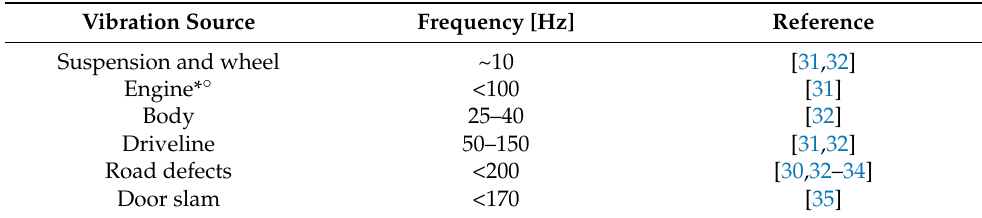
Table 1. Sources of vibration. Frequency value for (*) a light truck equipped with automatic transmis- sion, 787 mm tires, traveling at 80 km/h in overdrive, and ( ◦ ) assuming a maximum engine speed of 6000